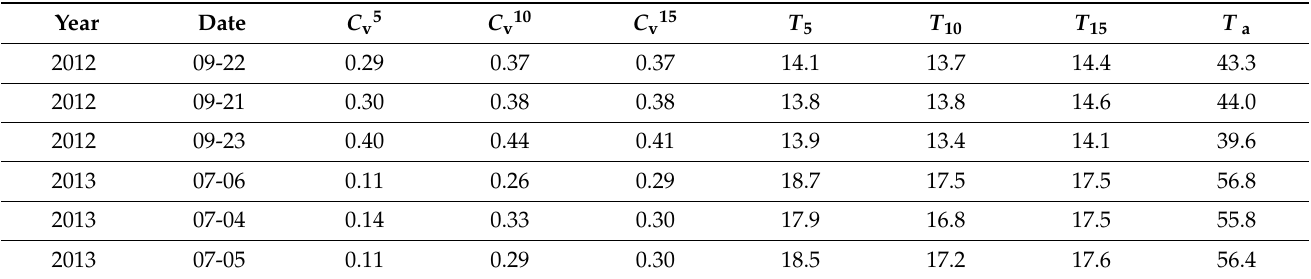
Figure 4. Scatter plot between daily average temperature and day sequence from March to July of each year (missing data for April 2012 and May 2014). Table 4. Temperature indicators data of BOMI station in training and validation phase in 2012–2015 (unit: ◦